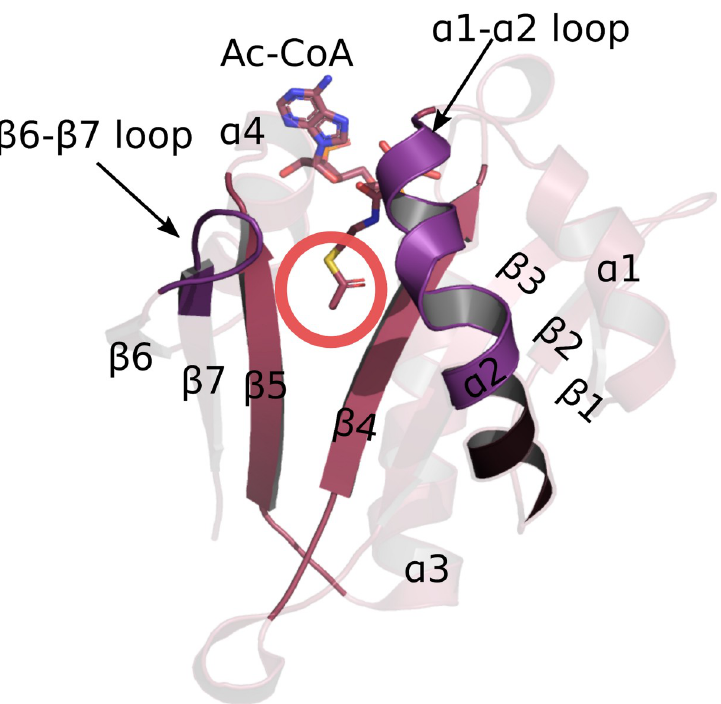
Fig 1. GNAT fold is the acetylation scaffold in the acetyltransferase superfamily. The fold positions the two substrates in such a way that the acetyl group of Ac-CoA approaches the N-terminus of the protein acceptor in the middle of the V-shaped splay between β 4 and β 5 strands–marked with the red circle. Four structural motifs have been identified in the GNAT fold: motif A consists of the β 4 strand and α 3 helix, motif B is the β 5 strand and α 4 helix, motif C includes the β 1 strand and α 1 helix, and motif D consists in the β 2 and β 3 strands [2].